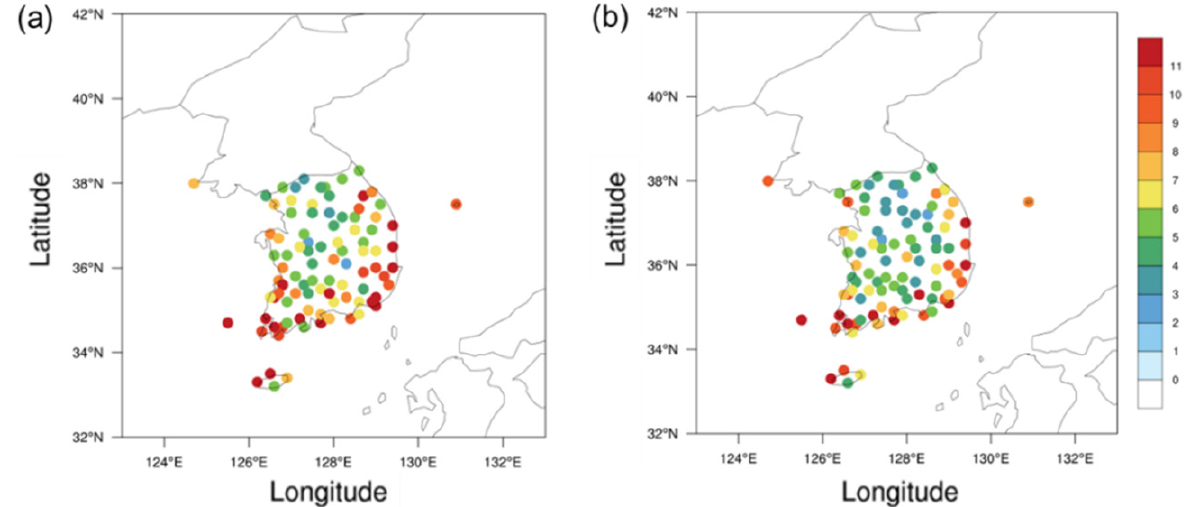
Figure 6. Spatial distributions of observed maximum wind speed at 10 m (MWS) for typhoon ( a )